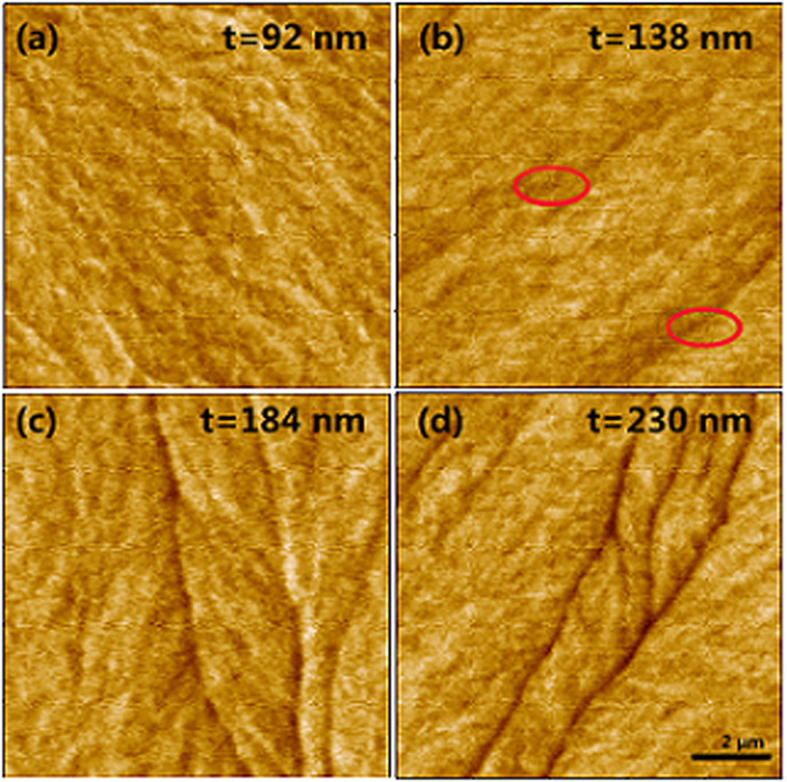
MFM pattern of Co81Ir19 films with t = 92 nm, 138 nm, 184 nm, 230 nm.